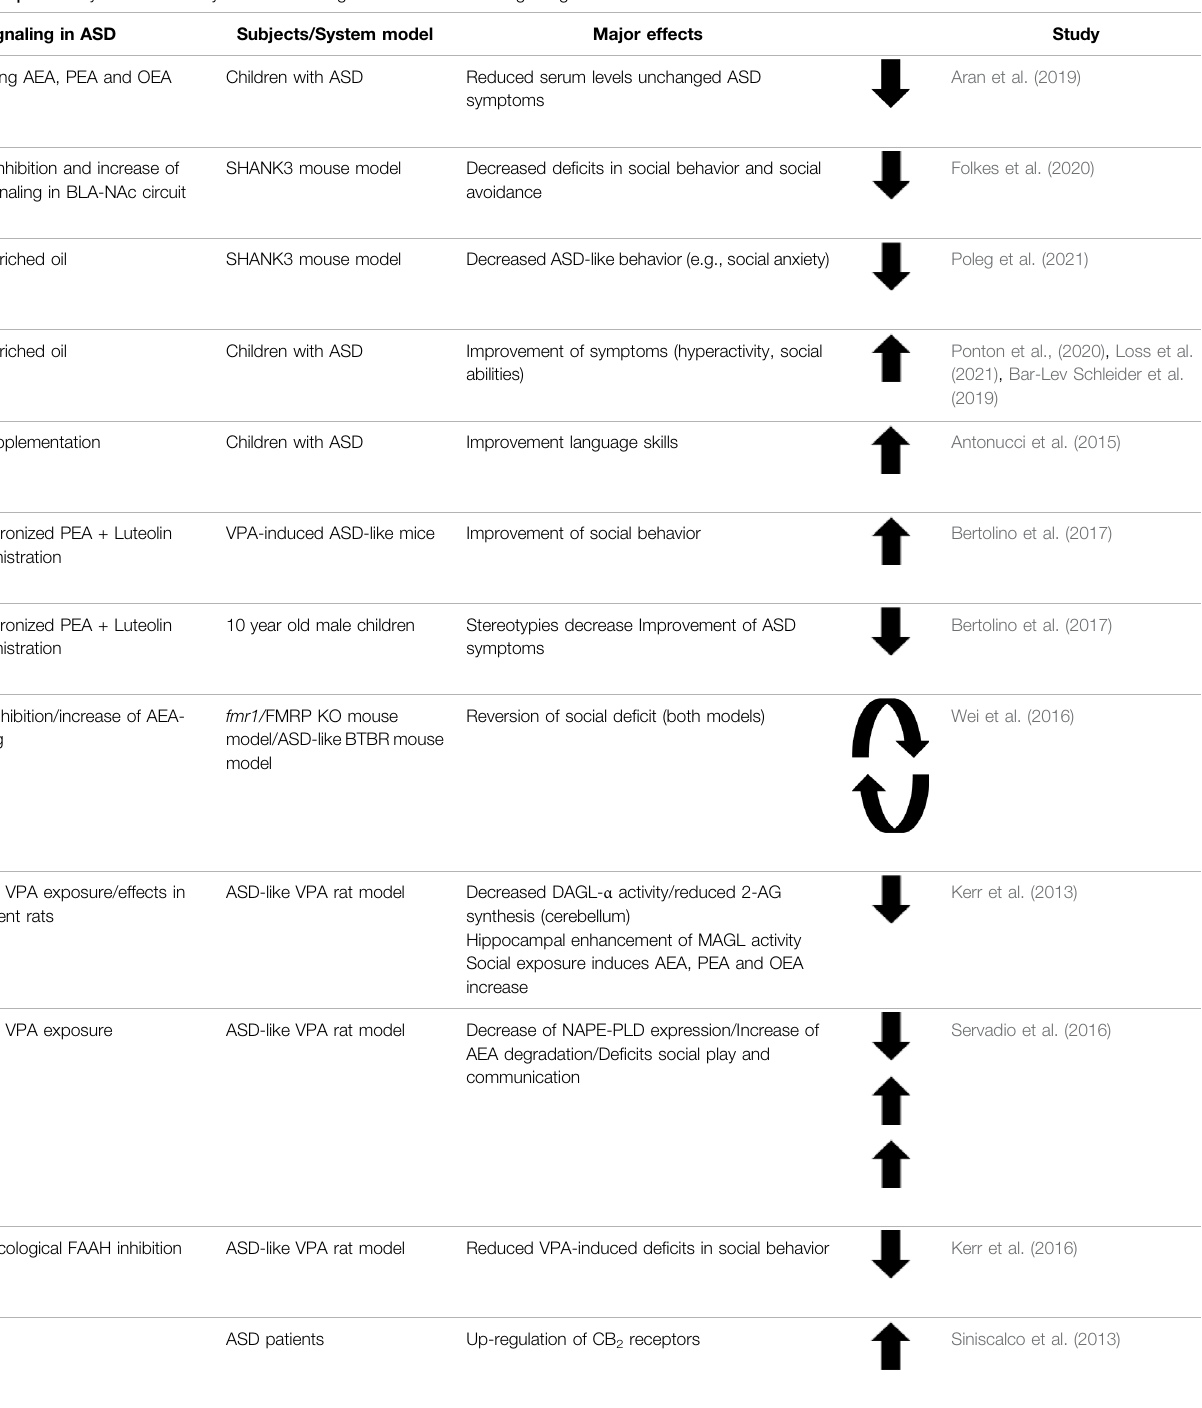
TABLE 1 | Summary table of the key studies showing involvement of eCB signaling in